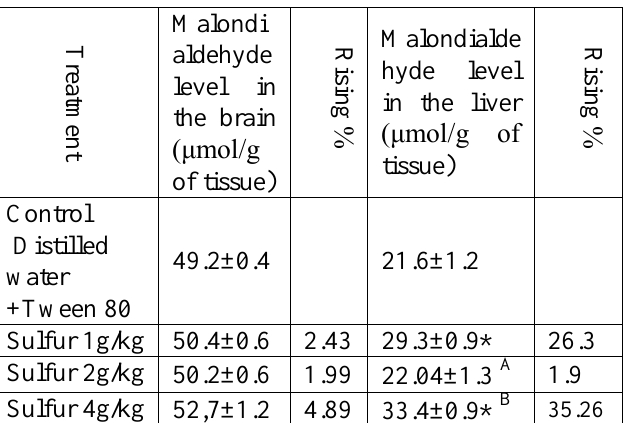
Table 8: Effect of sulfur ( 16g/kg b.wt) on the activity of ALY and AST Enzyme in plasma of mice after